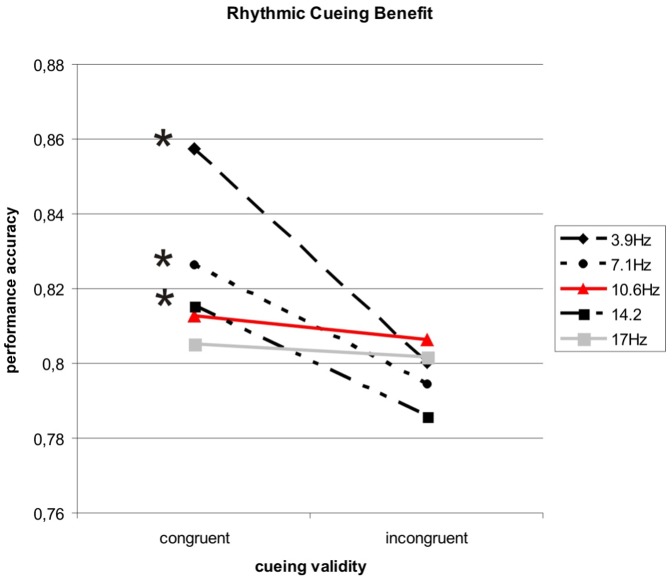
Results Experiment 1.Group averaged accuracies for target discrimination at congruent and incongruent locations as a function of the five cueing frequencies (exploring a significant Congruency×Frequency interaction). In spite of spatially non-predictive cueing, significant cueing benefits (higher accuracy at cued relative to uncued locations) were observed for cueing at 3.9 Hz, 7.1 Hz, and 14.2 Hz but broke down for intermediate 10.6 Hz cueing in the alpha-band (8–12 Hz). At the highest frequency of 17 Hz, rhythmic cueing no longer led to cueing benefits. *: significant cueing benefits at p<0.05.